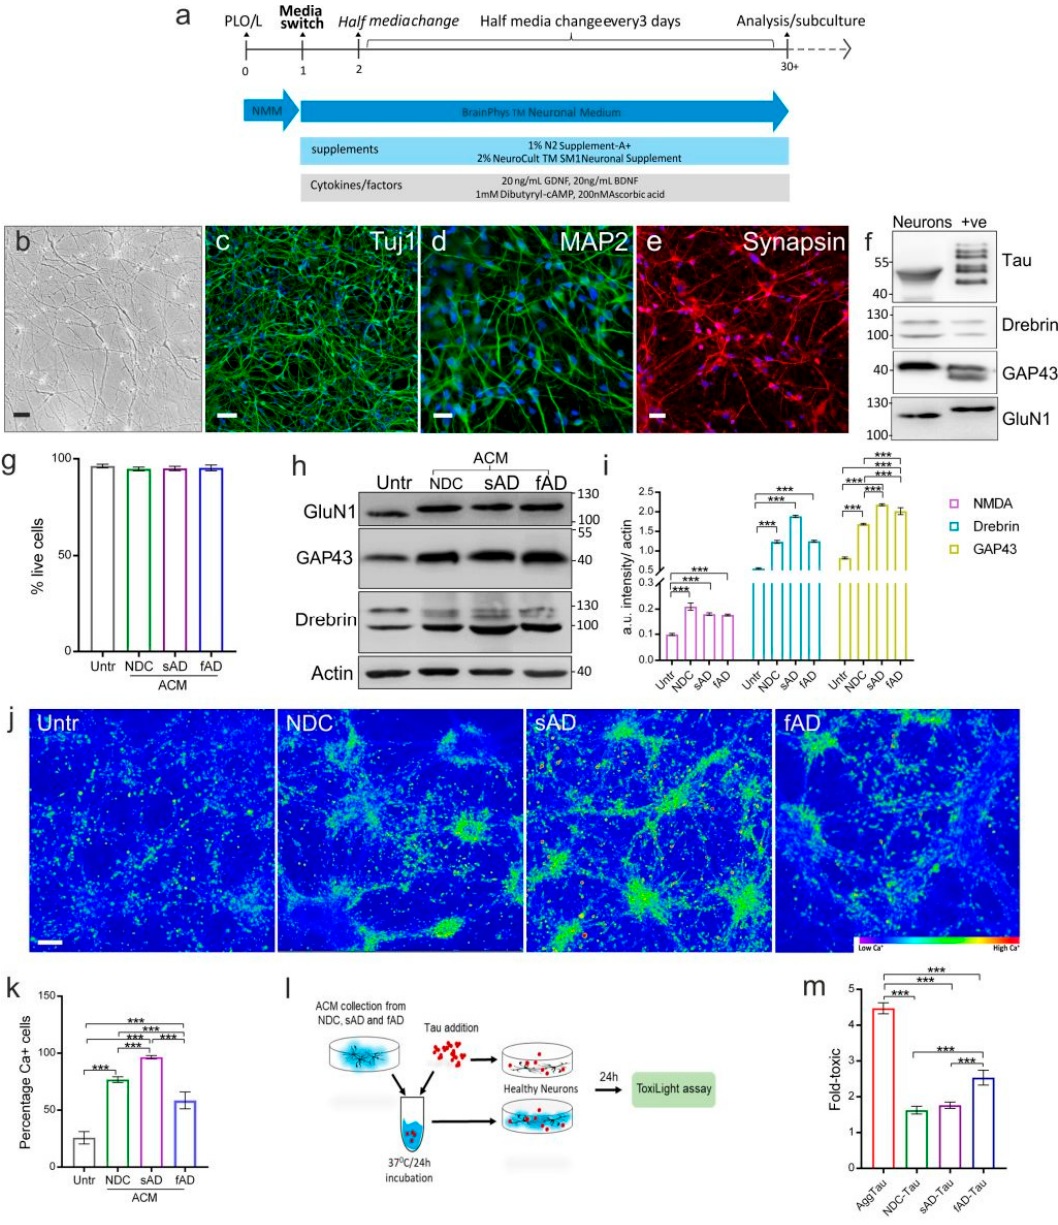
Figure 7. Impact of ACM on iPSC-derived healthy neurons upon glutamate stimulation. ( a ) Scheme showing differentiation of neurons from iPSC-derived NSCs. ( b ) Phase-contrast image of differentiated neurons. Scale bar: 50 µm. Representative images of neurons positive for the neuronal markers ( c ) β -tubulin III (Tuj1), ( d ) MAP2 and ( e ) Synapsin. Scale bar: ( b , c ) 100 µm; scale bar: ( e ) 50 µm. ( f ) Characterization of neurons by immunoblotting using antibodies against Pan-Tau DC25, and markers Drebrin, GAP43 and GluN1. Human brain lysate was used as positive control for Drebrin, GAP43 and GluN1. ( g ) Graph showing percentage of viable neurons in untreated and ACM-treated groups. ( h ) Representative immunoblots of neuronal extract after 5-day subculture with ACM supplementation from NDC, sAD and fAD astrocytes. Actin was used as loading control. ( i ) Graph showing increased levels of synaptic markers GluN1, Drebrin and plasticity marker GAP-43 in presence of ACM from NDC, sAD or fAD, when compared to untreated neurons. ( j ) Wide field images showing calcium influx in neurons upon glutamate stimulation in presence of ACM from NDC, sAD and